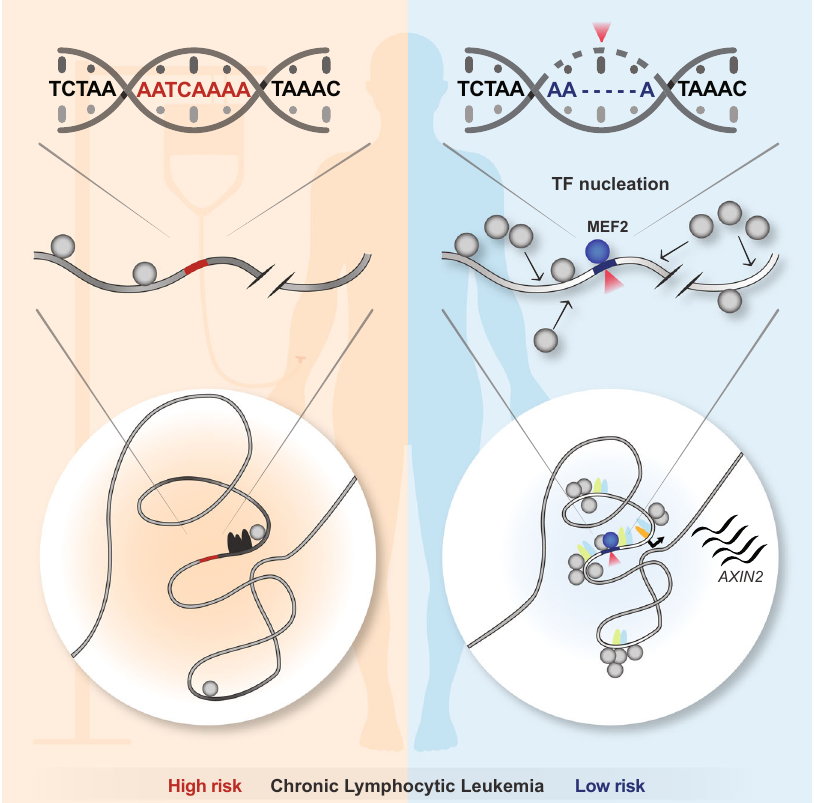
Fig. 7 Graphical summary. Our data support a model in which a non-coding, germline 5 bp deletion activates a set of long-range enhancers by creating a de novo MEF2 TF motif, which in turn triggers AXIN2 expression. MEF2 presence correlates with long-range TF nucleation and chromatin compaction, suggesting that these phenomena are major drivers of AXIN2 VCM formation. In addition, this 5 bp deletion and AXIN2 expression are associated with reduced CLL predisposition and disease